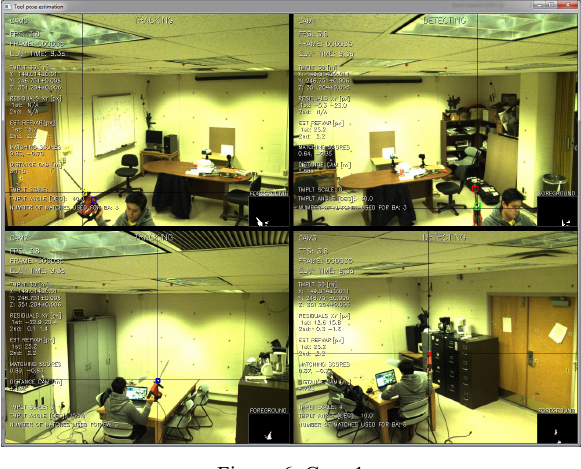
CAM0 and CAM1 tracked and detect wrong objects